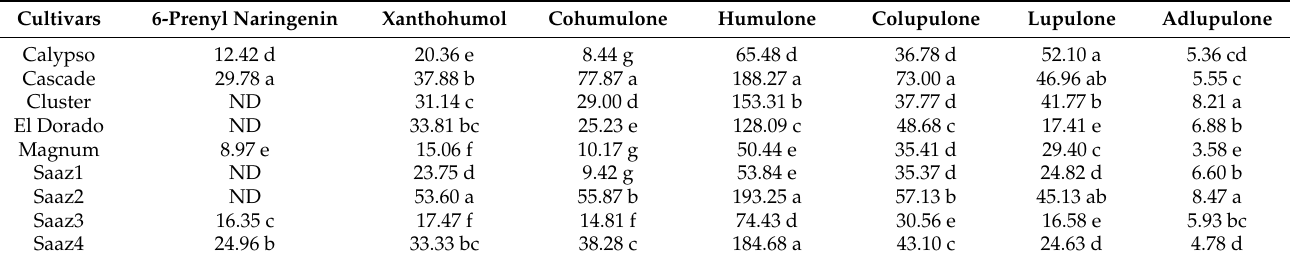
Table 2. Concentration of different prenylflavonoid compounds in hop